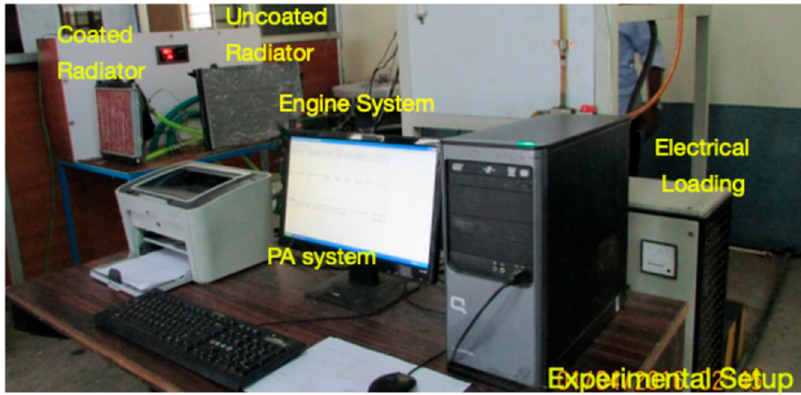
Figure 2. Experimental schematic diagram and Thermocouple Position in Radiator.